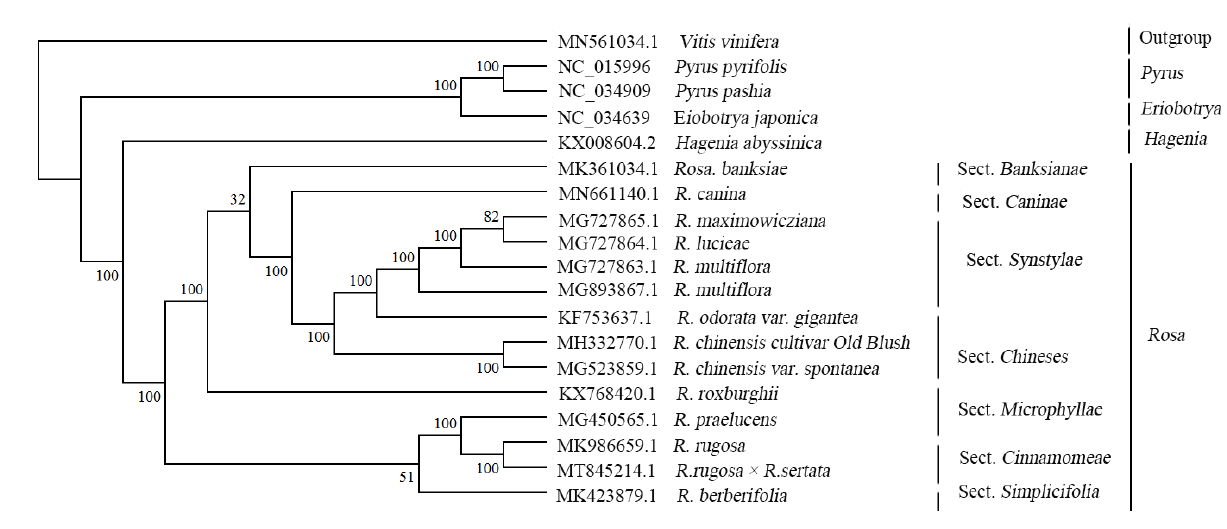
Figure 2 – Maximum likelihood (ML) phylogenetic tree of 18 species of Rosaceae constructed using their chloroplast genomes. Vits vinifera was used as the